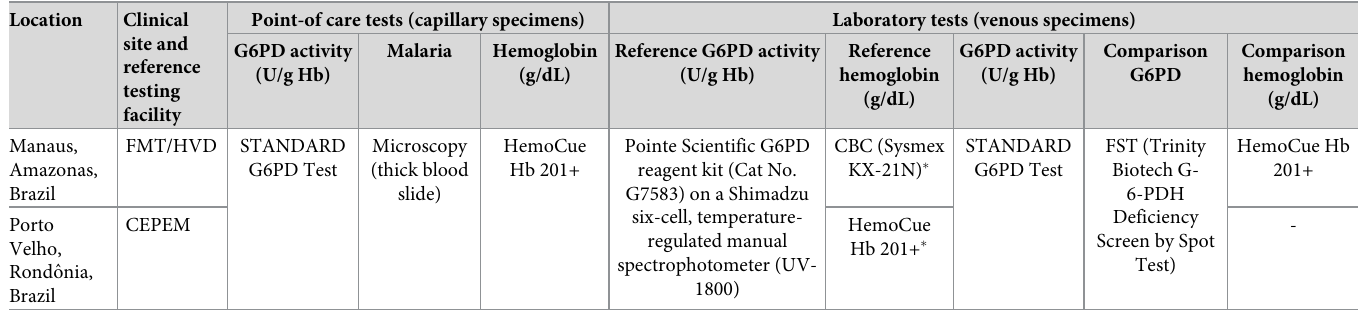
Table 1. Summary of study